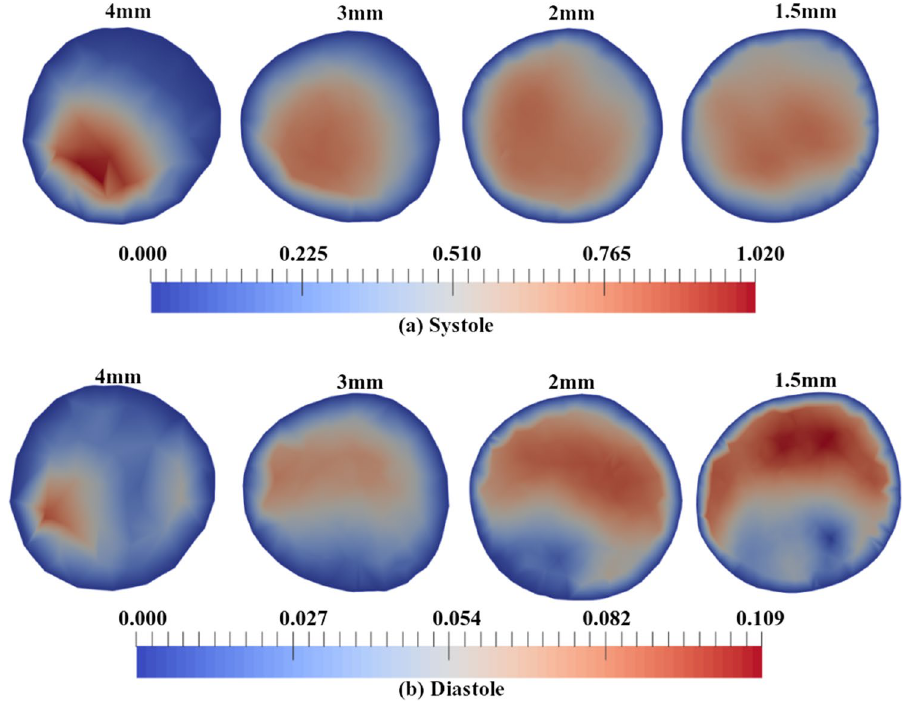
1 Figure 5. Velocity magnitude ( ms − ) contours at the inlet plane determined from 4D-Flow MRI data for all 4D-Flow MRI spatial resolutions over the systolic and diastolic phases.